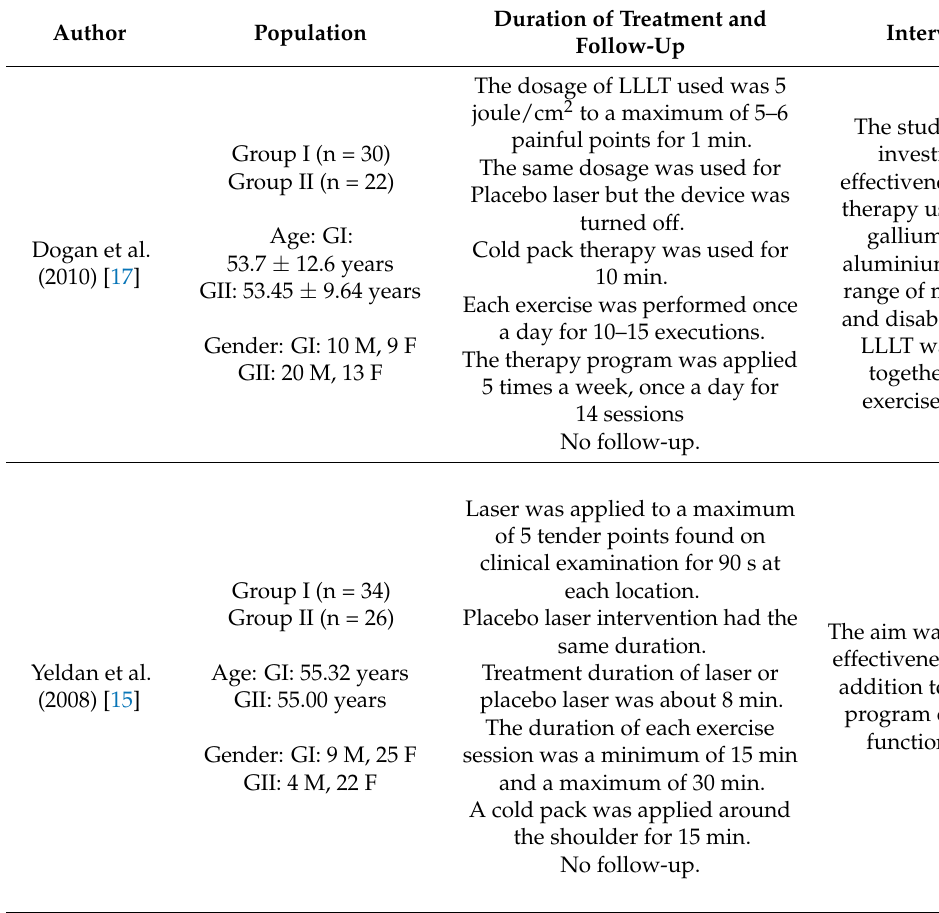
Table 2. Characteristics of the